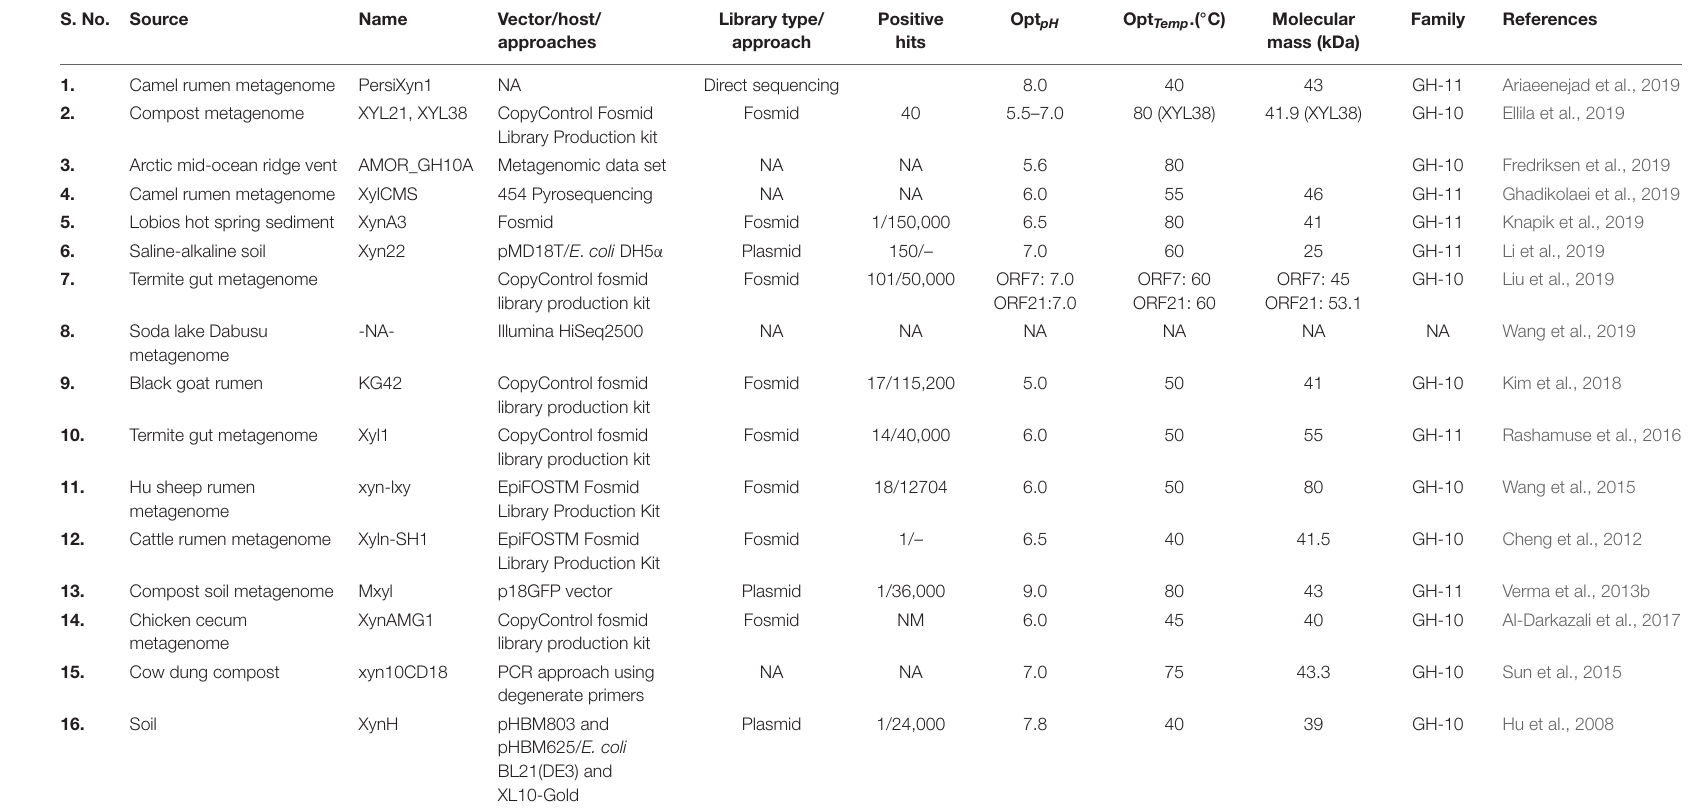
TABLE 1 | An update of metagenomic GH-10 and GH-11 endoxylanases. S. No.